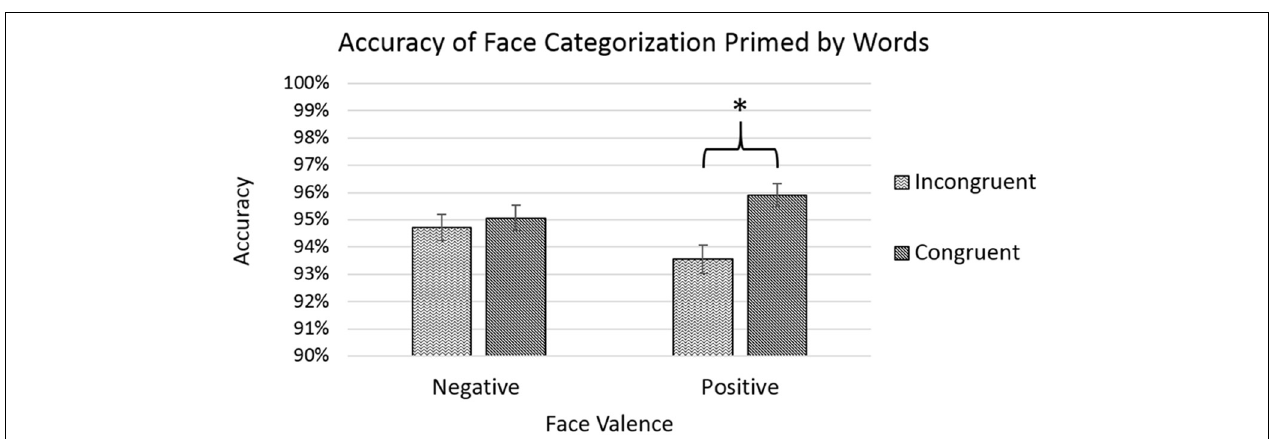
Frontiers in Psychology |